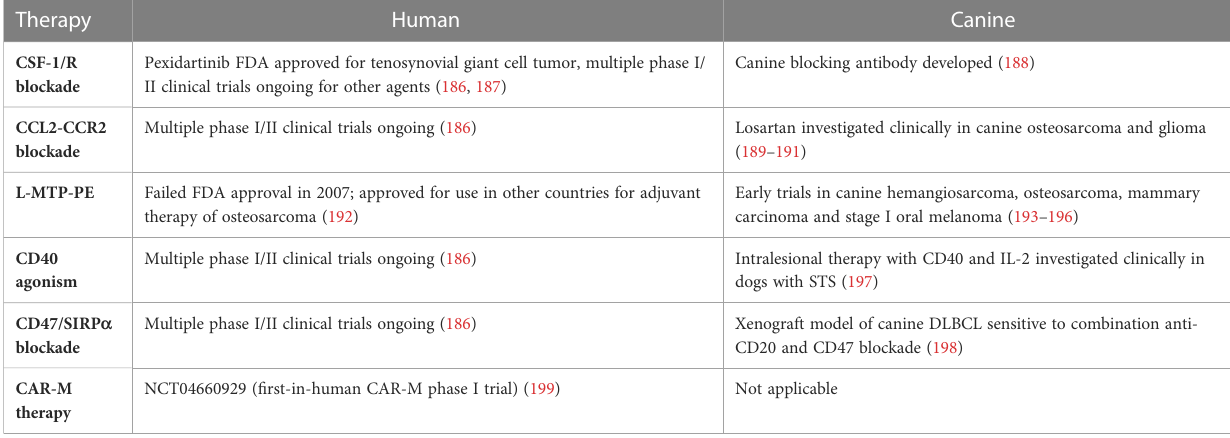
TABLE 4 Select comparative macrophage-based cancer therapies in humans and dogs.